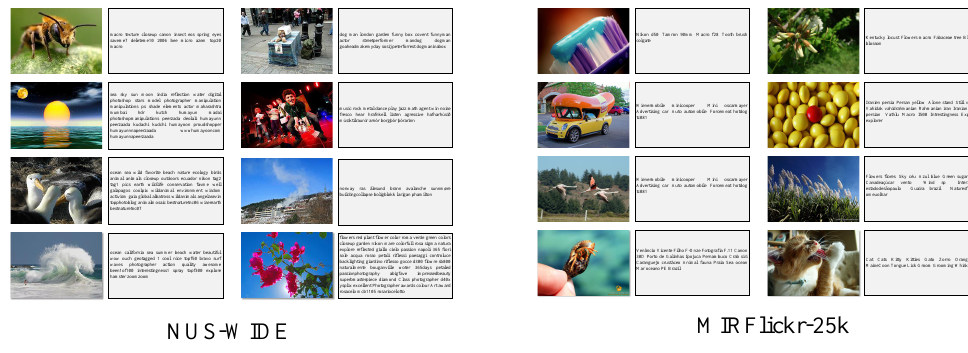
Figure 2. Some examples from the MIRFLICKR-25K and NUS-WIDE datasets. Table 2. Statistics of the datasets in our experiments. Dataset Total Train/Query/Retrieval Labels Text